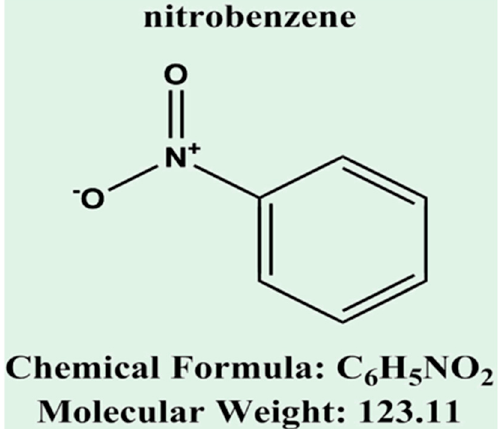
Figure 1. The molecular structure of Nitrobenzene (NB).